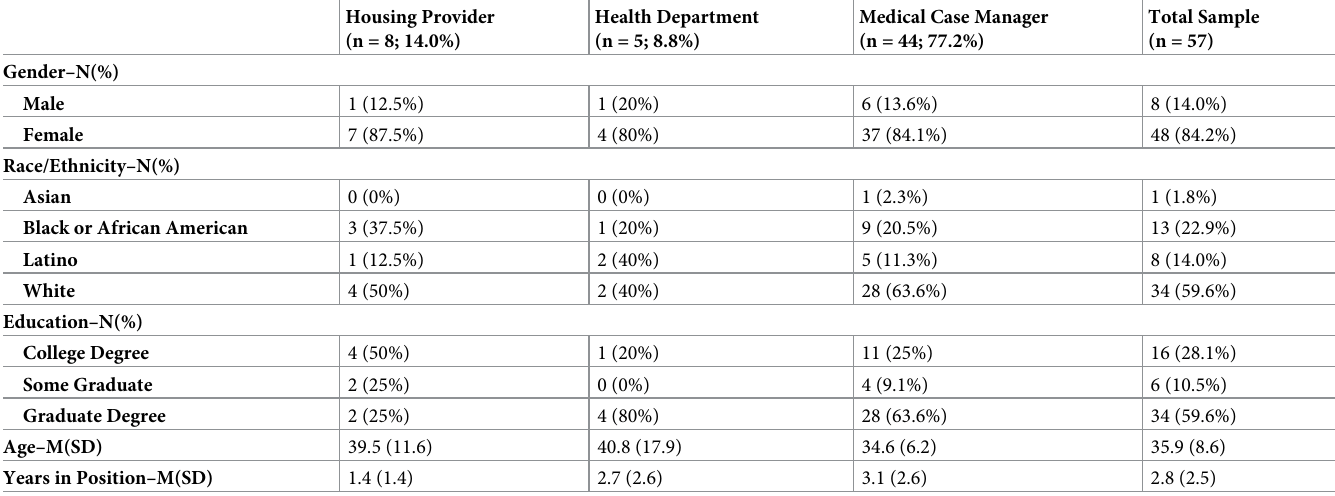
Table 1. Sample characteristics separated by respondent